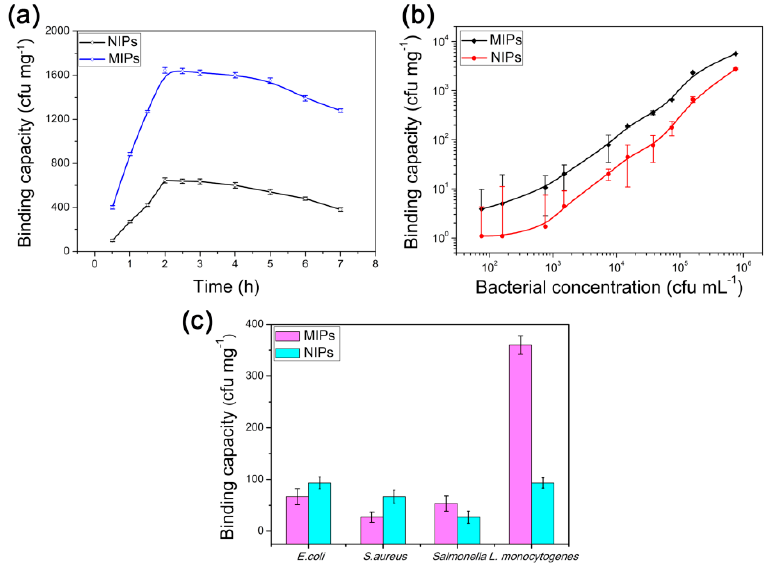
Figure 5. ( a ) Kinetic data of MIPs and NIPs, ( b ) static isotherm curve of MIPs and NIPs, and ( c ) the selectivity adsorption of MIPs and NIPs on four bacteria mixing solutions.